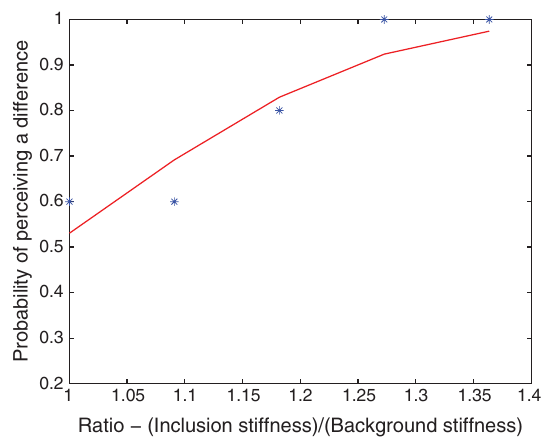
Fig. 18. Psychometric function estimated on the test with the Kalman filter stiffness estimation. The ∗ are the experimental data, the line is the fitted Weibull